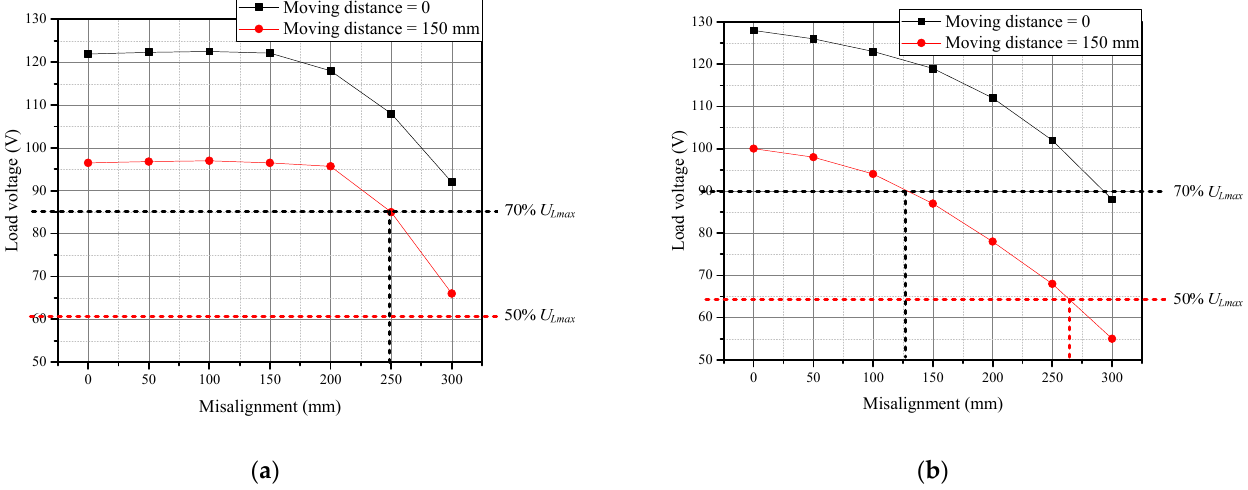
Figure 14. Output characteristics of two receivers with different misalignments from the maximum mutual inductance position and the minimum mutual inductance position: ( a ) the dual-phase NSP receiver; ( b ) the dual-phase DD-OQO receiver.